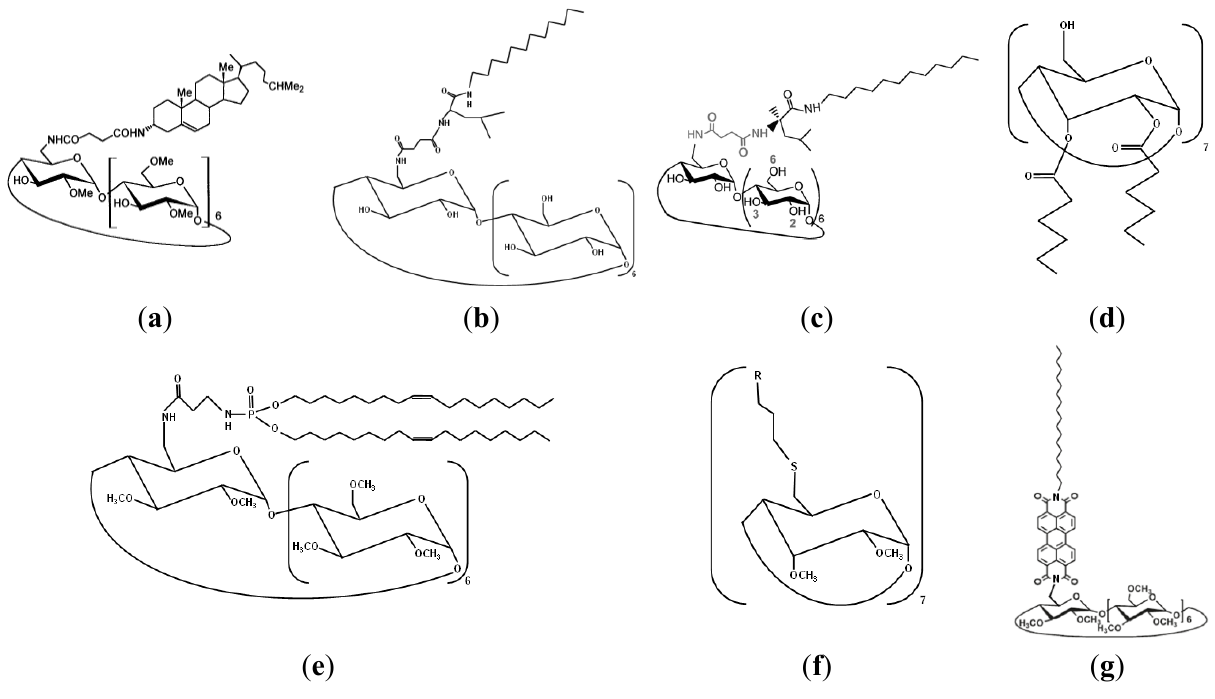
Figure 1. Amphiphilic cyclodextrins obtained by modifications of the